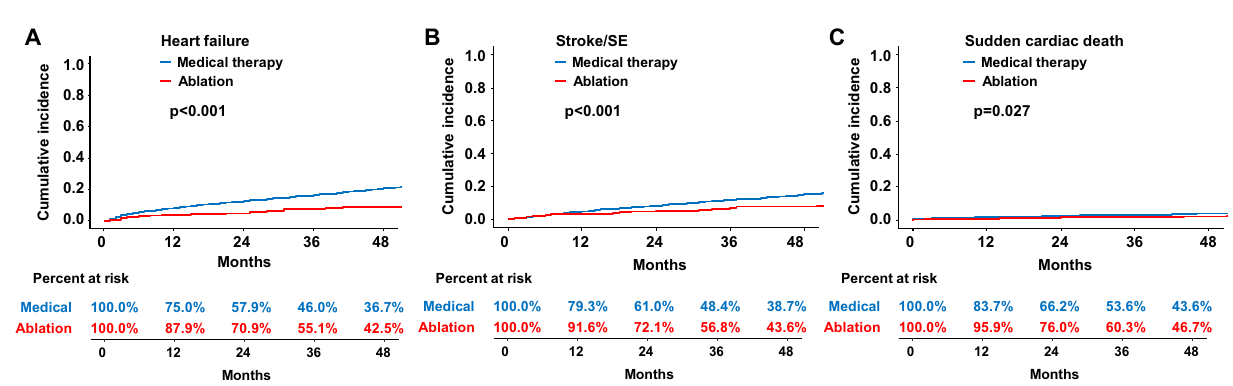
Figure 5. Weighted cumulative incidence curves of ( A ) heart failure, ( B ) ischemic stroke/SE, and ( C ) sudden cardiac death for patients with ablation or medical therapy. SE, systemic embolism. Figure prepared in R software (version 3.6.1, R Core Team, 2019, Vienna, Austria) 22